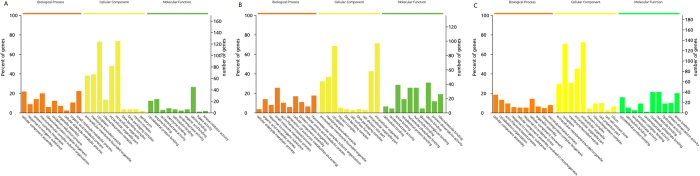
Most significant enriched GO terms of differentially expressed proteins at each time point.(A) 24 h; (B) 48 h; and (C) 96 h.